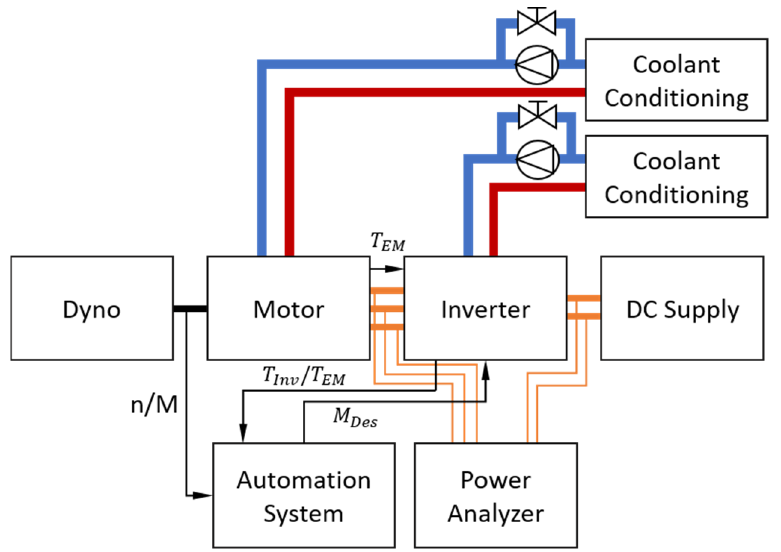
Figure 2. Measurement setup of motor and inverter for the temperature-dependent efficiency evaluation with active component conditioning [30].